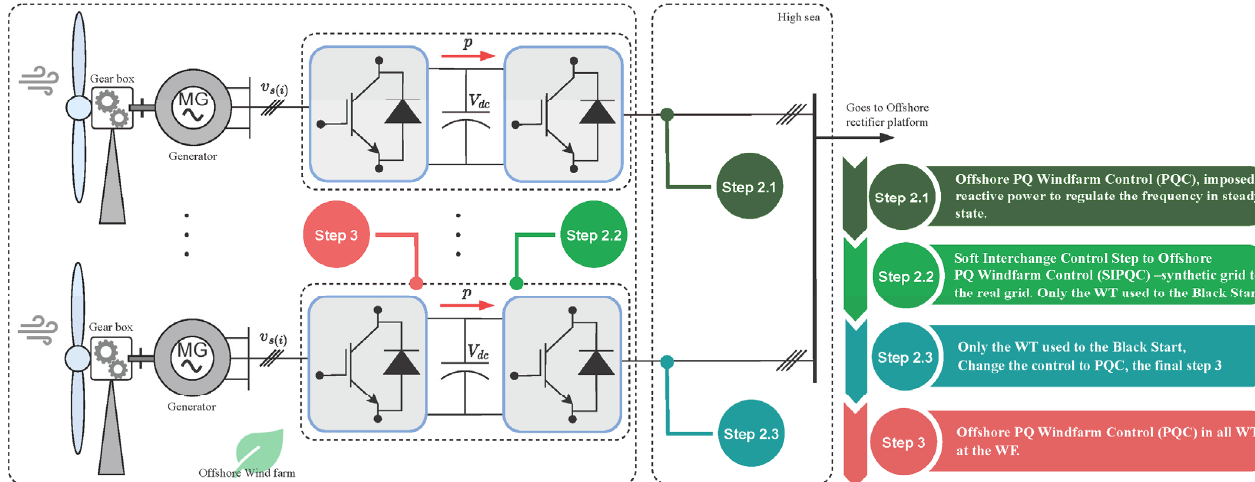
Figure 5. Black Start Non-Linear Control Diagram (CIS).